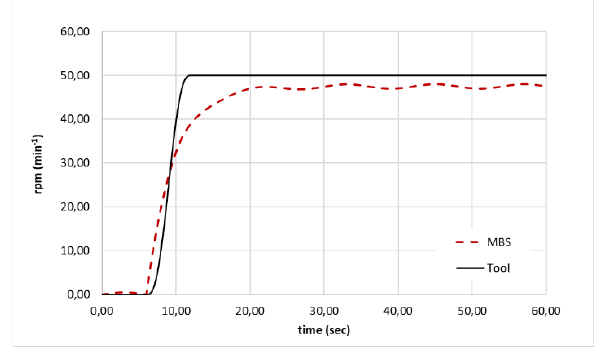
Fig. 6. results of MBS simulation.